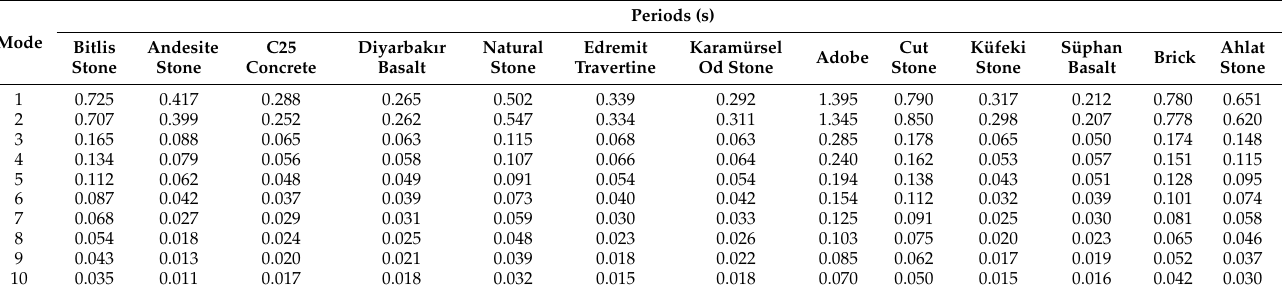
Table 11. ANN results in natural fundamental period estimation.